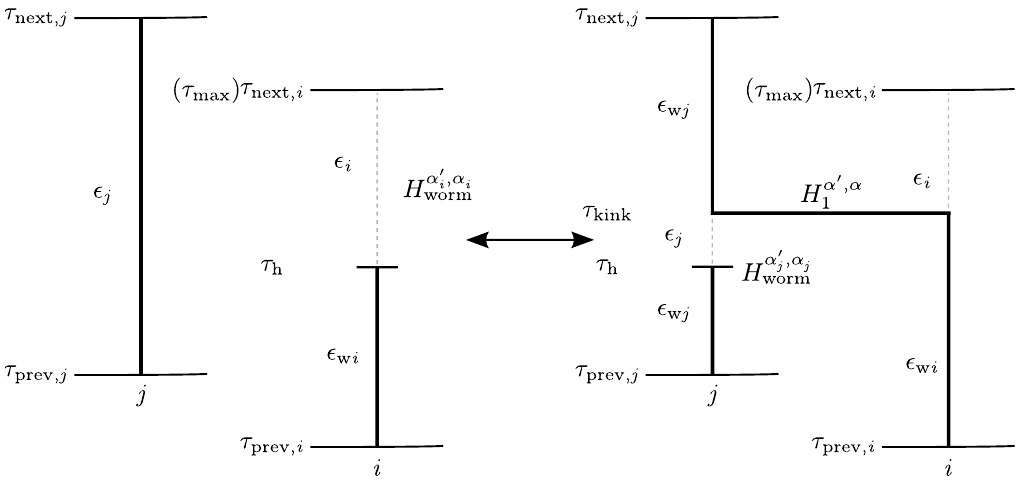
Figure 18: Insert / Delete kink after head. A kink is inserted between